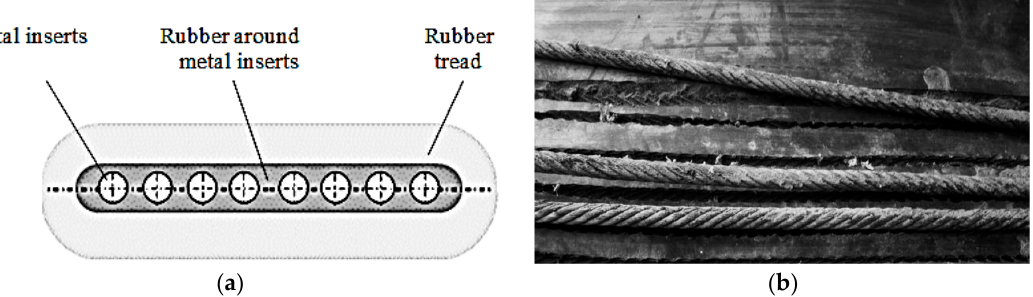
Figure 1. Structure of conveyor belt waste with metal insert. ( a ) waste structure; ( b ) image conveyor belt waste. Table 1. The rubber structure around the metal insertion.